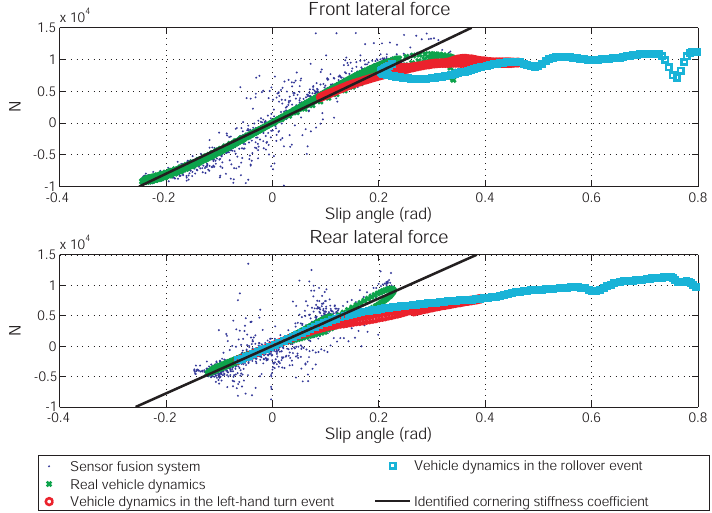
Figure 11. The relations between the slip angle and the lateral tire adhesive